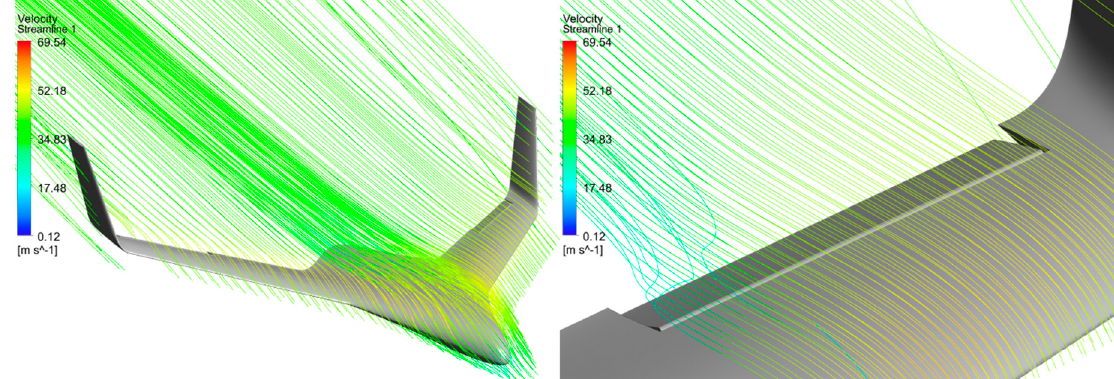
Figure 11. Streamlines around the BWB UAV reference configuration ( left ) and flow development over the deflected elevon control surface at a deflection angle of 10 degrees ( right ). The angle of attack is 8 degrees.